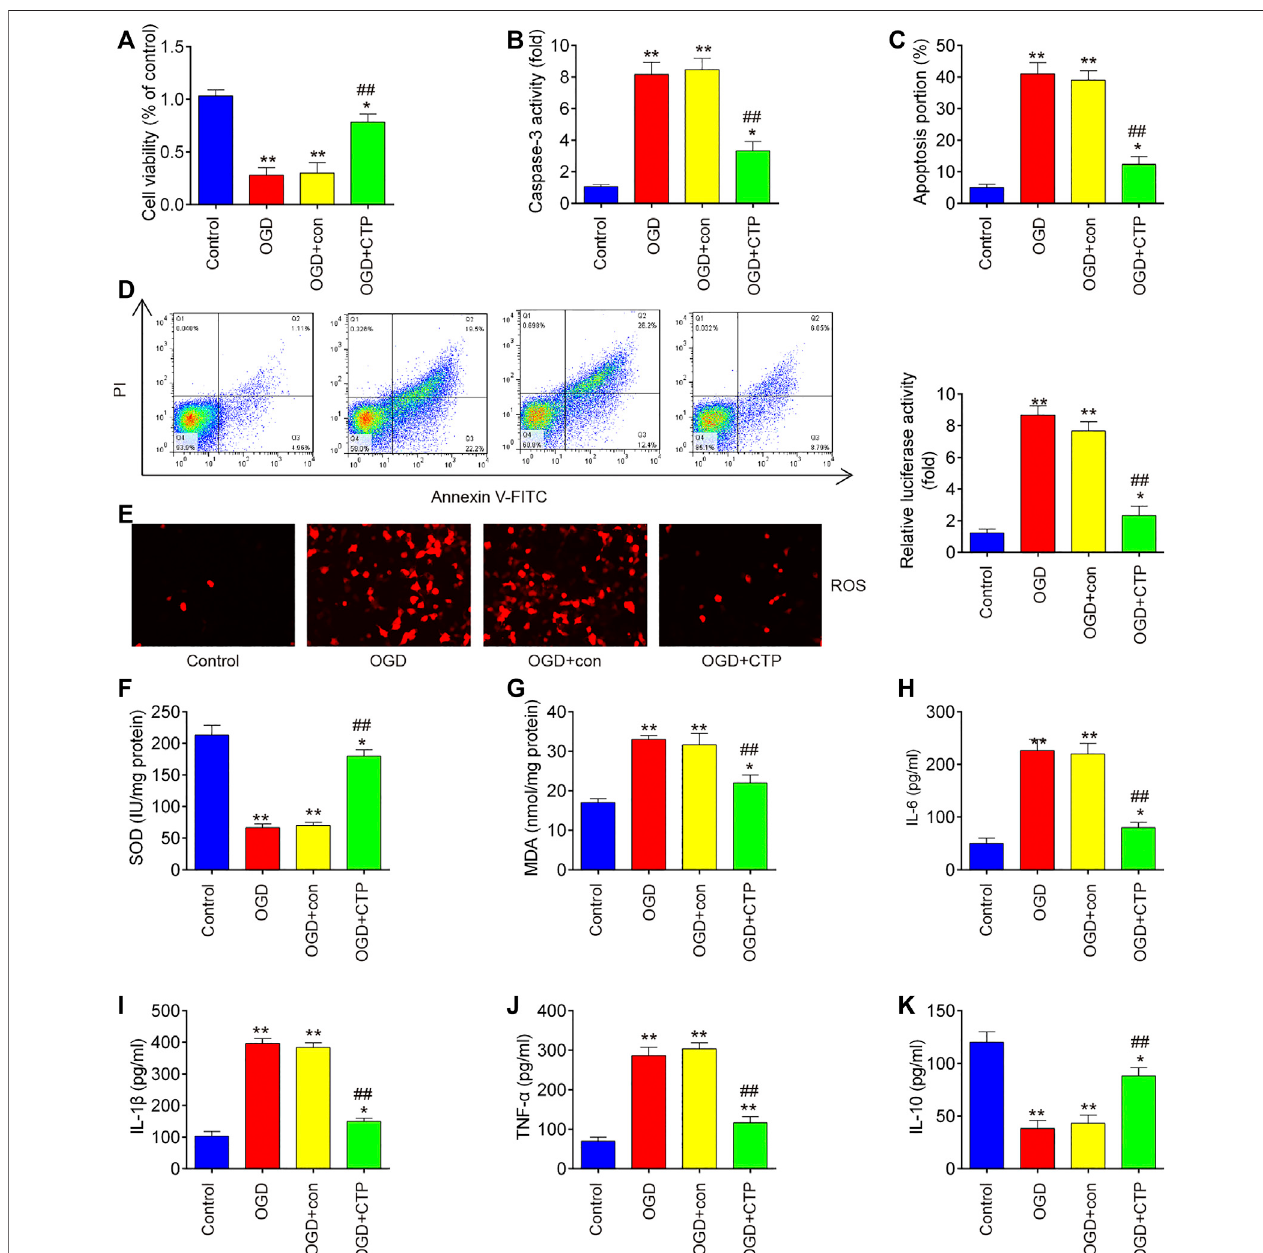
FIGURE 5 | Catalpol reduces apoptosis, oxidative stress and in fl ammation in SCI cell model. (A) Cell viability was assessed using CCK-8 assay. (B) Activity of caspase-3wasmeasuredusingacaspase-3ActivityAssaykit. (CandD) Apoptosiswasmeasuredusing fl owcytometry. (E) ROSgenerationwascalculatedusing2,7- DCF-DAstainingkit (FandG) ThecontentsofMDAandSODweremeasuredbycommercialkits. (H – K) Thein fl ammatorycytokinesincludingTNF- α ,IL-1 β ,IL-6andIL- 10, were evaluated by ELISA assays. Data represent the mean ± SD of three independent experiments. * p < 0.05, ** p < 0.01 vs. Control group; ## p < 0.01 vs. OGD/G